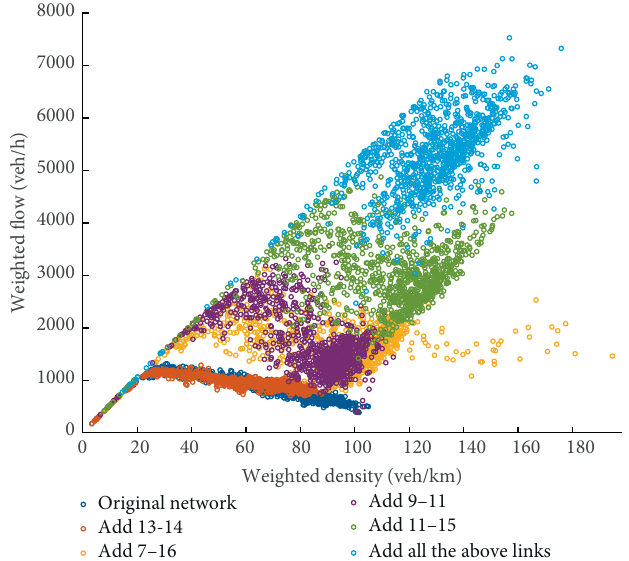
Figure 6: MFDs of different extended Sioux Falls networks.